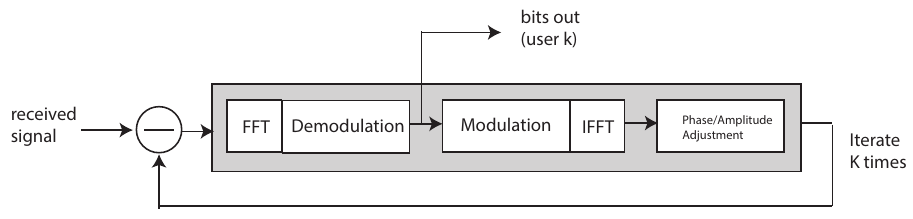
Figure 1. Block diagram of a typical successive interference cancellation